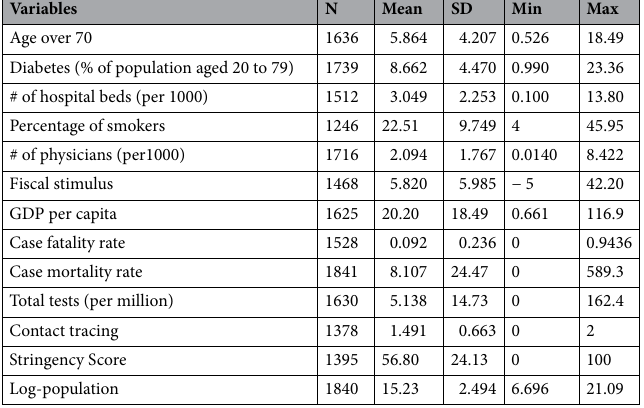
Table 1. Descriptive